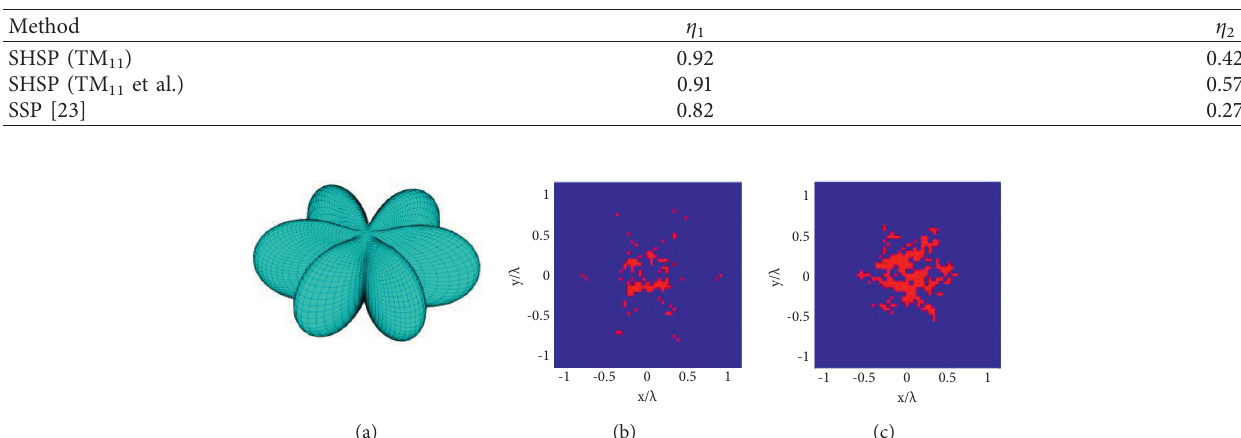
and η calculated for the star-shaped target from Figure 11(a). 1 2